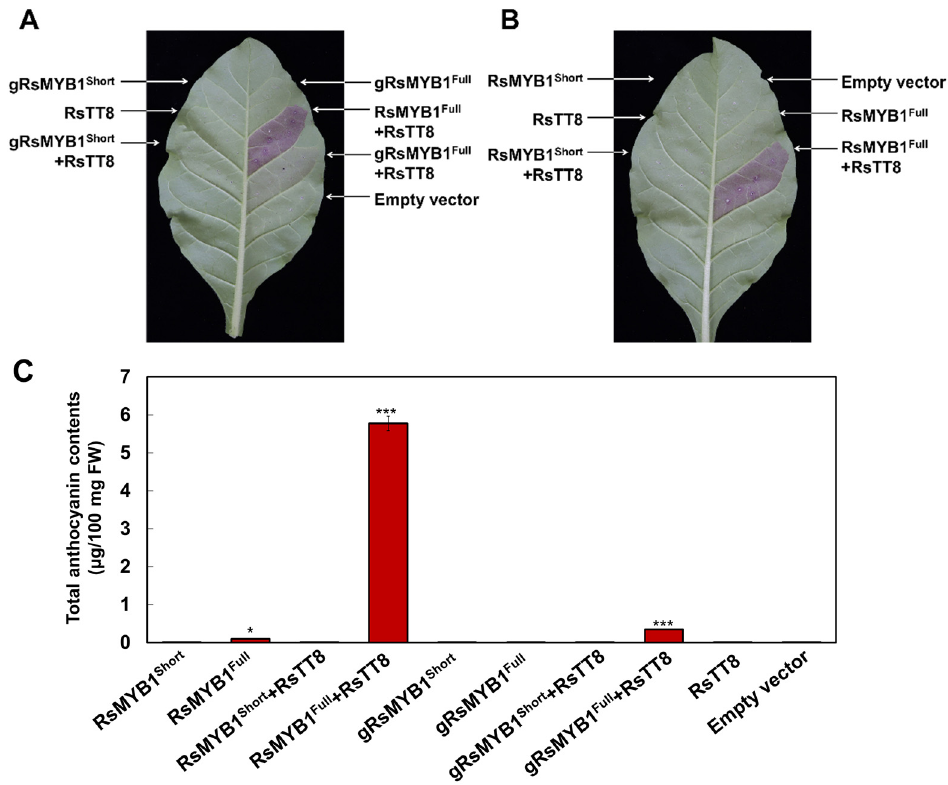
Figure 7. Visible phenotypes and anthocyanin contents of tobacco leaves transiently expressing RsMYB1 constructs. ( A ) Tobacco leaves transiently infiltrated with constructs carrying the genomic sequence from RsMYB1 Short or RsMYB1 Full alone or together with RsTT8 . ( B ) Tobacco leaves transiently infiltrated with constructs carrying the cDNAs from RsMYB1 Short or RsMYB1 Full alone or together with RsTT8 . ( C ) Anthocyanin contents of the leaf sectors shown in A and B. Results are mean values ± SD from three independent biological replicates. * p < 0.05; and *** p < 0.001, as determined by Student’s paired t -test relative to the empty vector..